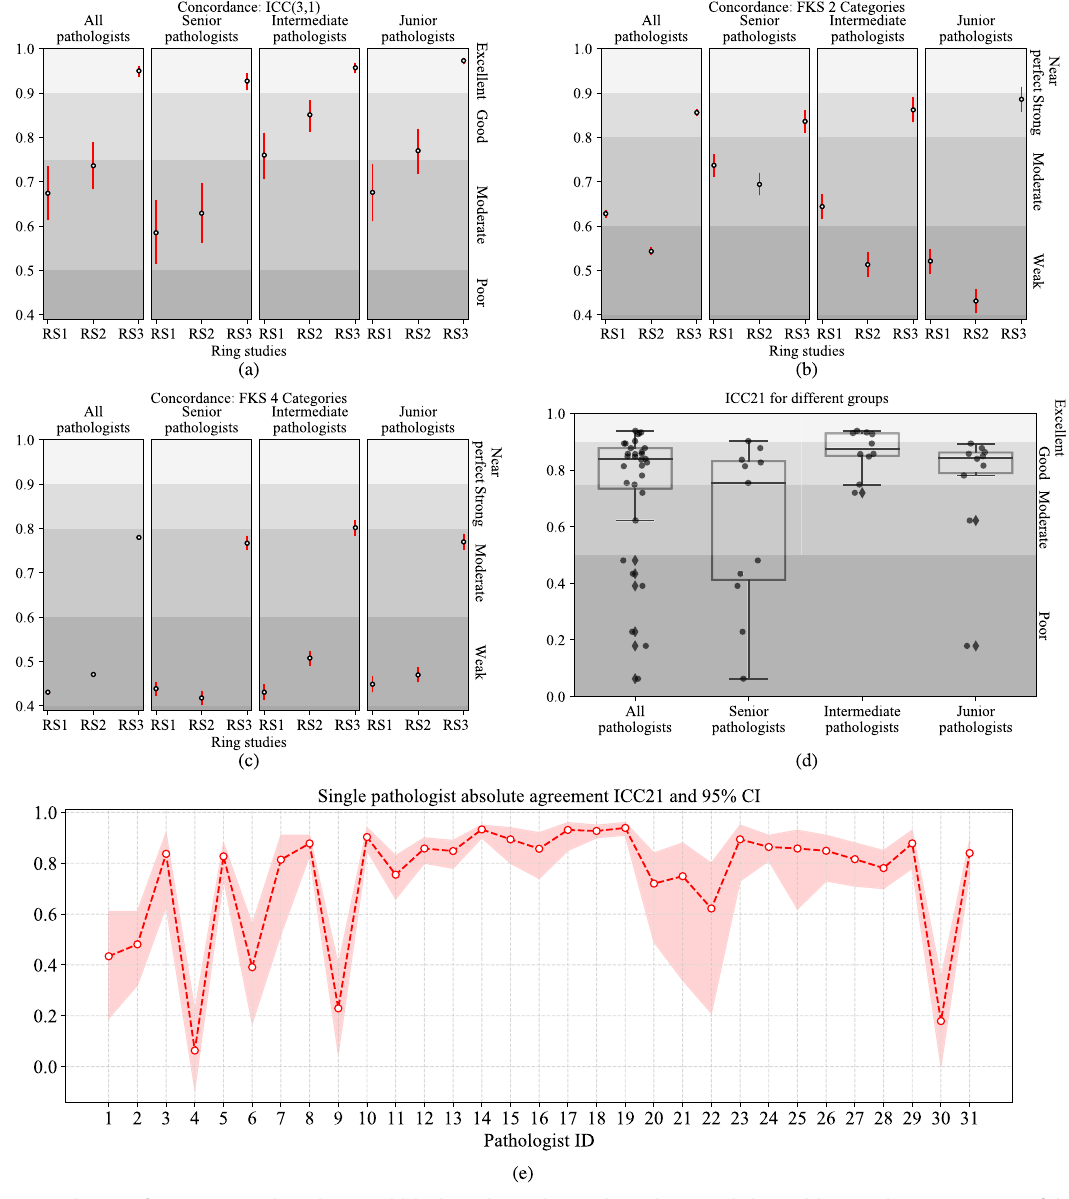
Fig. 3 The concordance of IC scoring. The white and black circles indicate the values, and the red bars indicate a 95% con fi dence interval. a Continuous concordances ICC31 in three-ring studies. b The FKS concordances for a 2-category score. c The FKS concordances for a 4- category score. d Boxplots of intra-pathologist concordances ICC21 between RS1 and RS2 for all and three levels of pathologists. The center bar of each box represents the median value, and the box body extends from the 25th to the 75th percentile of values in one group. Black circles indicate the ICC21 of the individual pathologists, and black diamonds indicate the outliers. e Intra-pathologist concordances ICC21 for individual pathologists between RS1 and RS2. The shadow area indicates the 95%